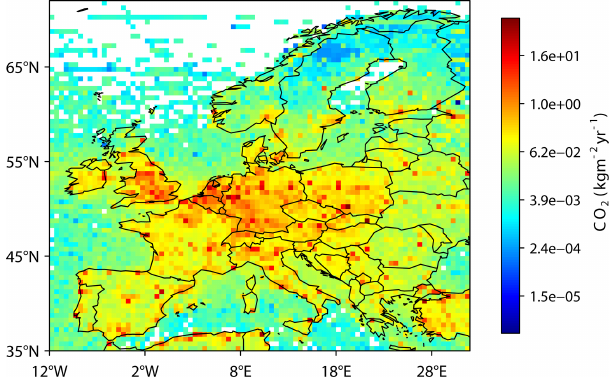
Figure 5. Map of annual mean fossil fuel CO 2 emissions (units of kgm − 2 yr − 1 ) plotted with a logarithmic (base of 2) colour